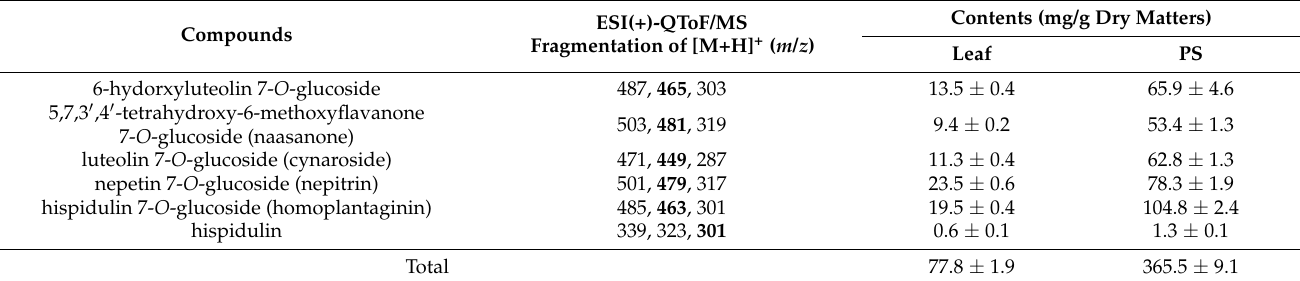
Table 3. Characterization of isolated flavone and flavanone derivatives from Plebeian sage leaf